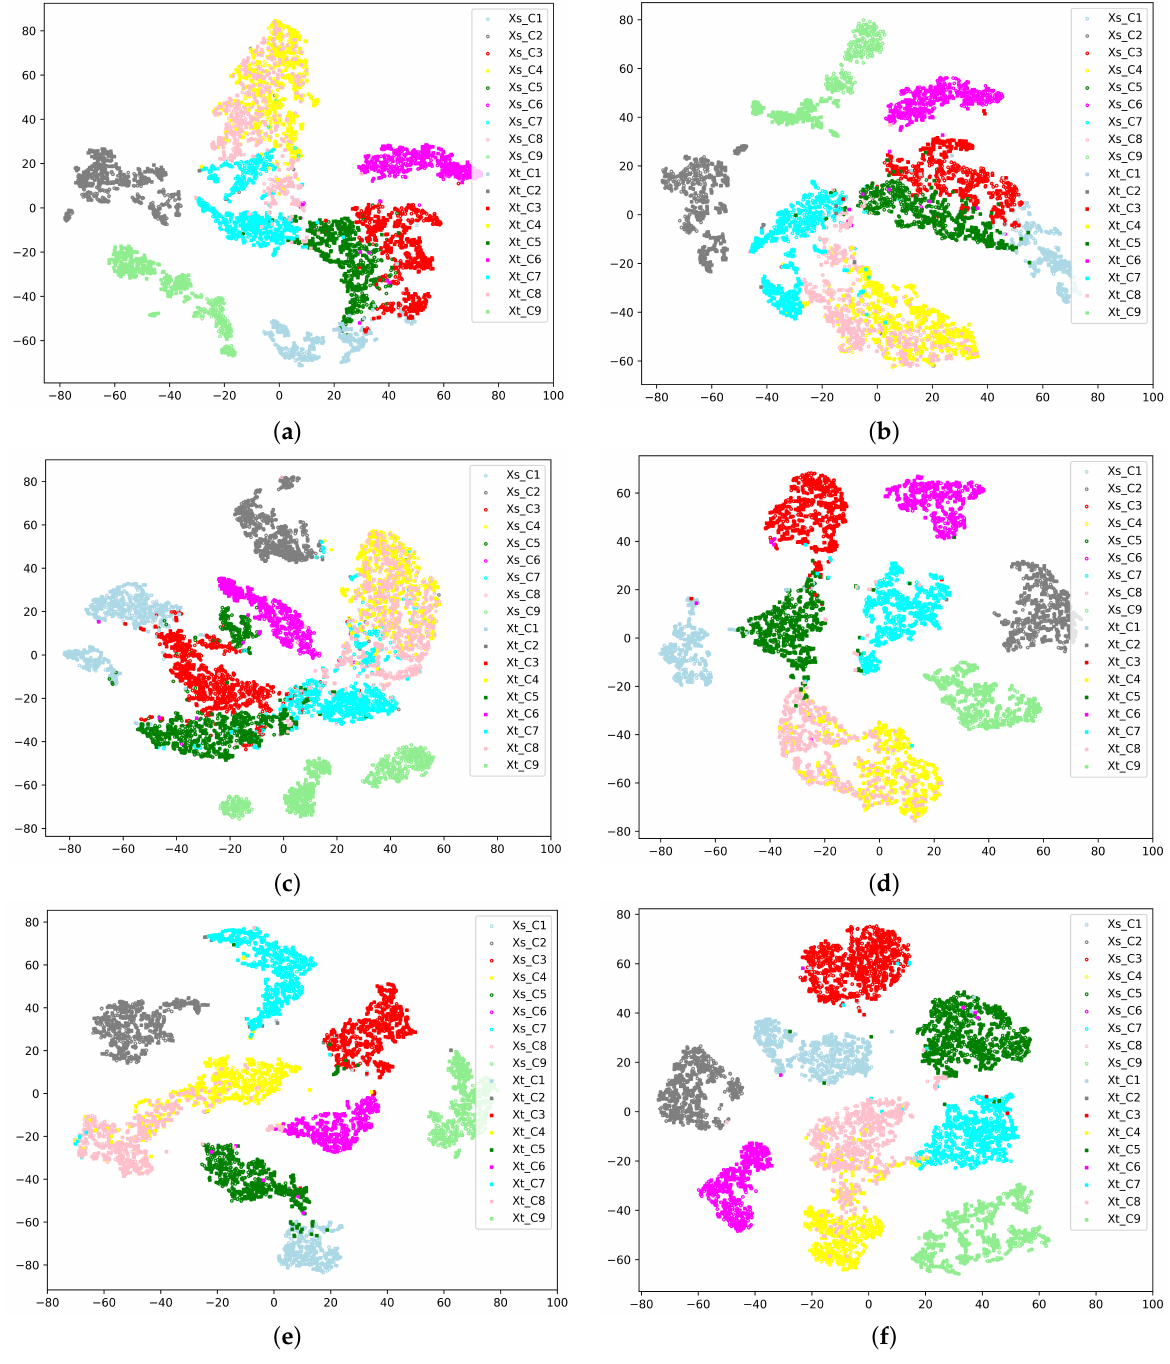
Figure 3. Illustrates the visualization of feature distribution. ( a ) Original features on BOT5-6 ( b ) Original features on BOT6–5 ( c ) Original features on BOT7–6 ( d ) CWDAN features on BOT5–6 ( e ) CWDAN features on BOT6–5 ( f ) CWDAN features on